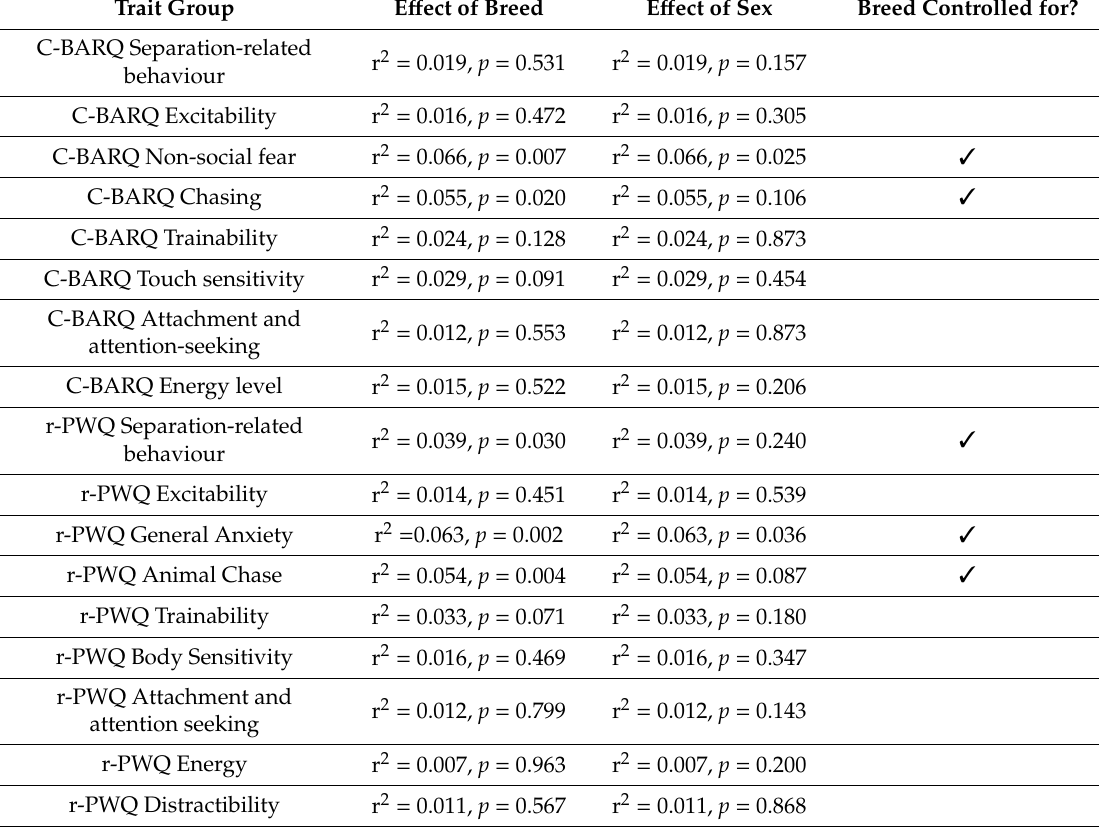
Table 4. E ff ect of breed and sex on C-BARQ and r-PWQ traits and whether breed was controlled for in trait scores. Trait